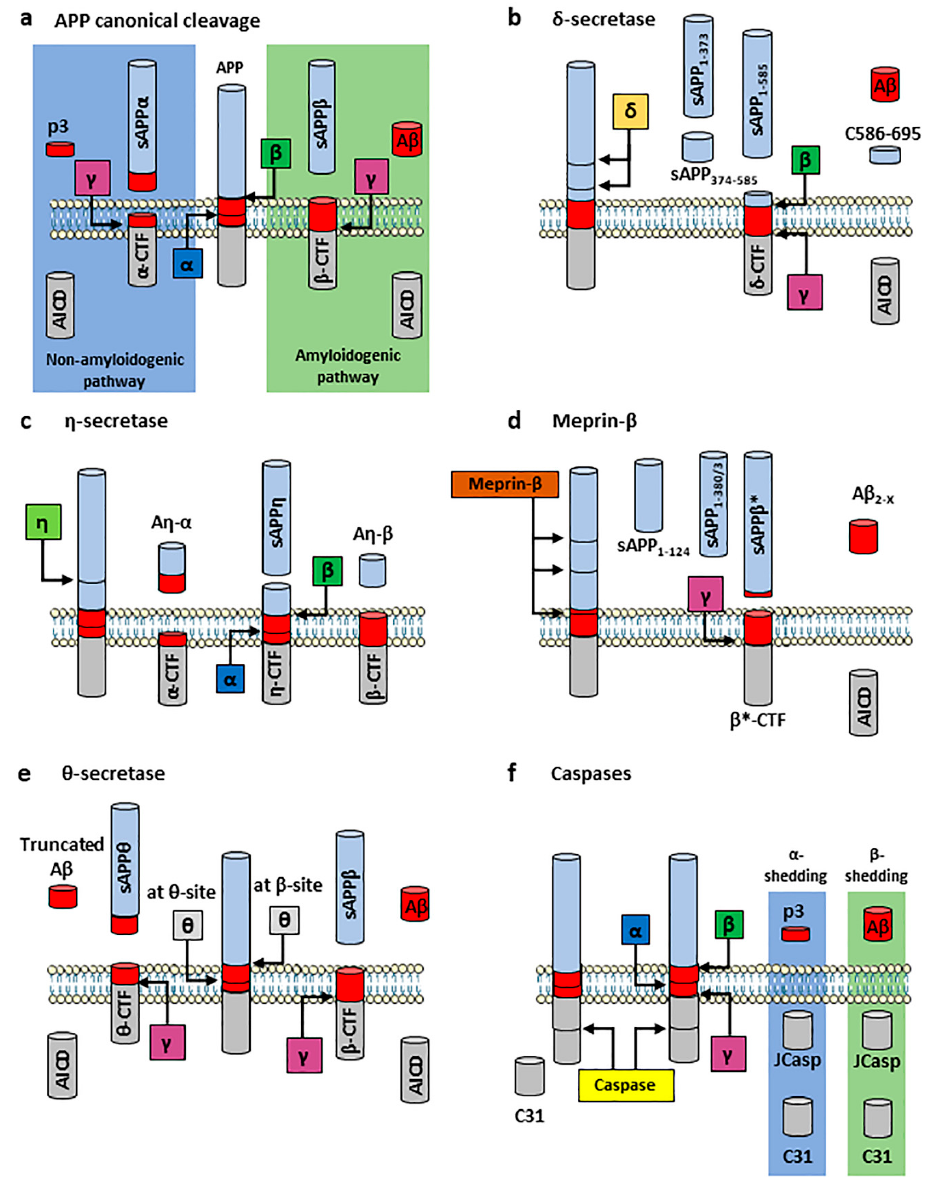
Figure 2. Schematic overview of APP-processing pathways. ( a ) APP canonical proteolytic processing. In the canonical cleavage, APP is either processed in the non-amyloidogenic pathway, where the sequential cleavage by α -secretase (ADAM10) ( blue square ) and the γ -secretase complex ( purple square ) produces sAPP α and p3, or in the amyloidogenic pathway, where the sequential cleavage by β -secretase 1 ( green square ) or Cathepsin B and the γ -secretase complex liberates sAPP β and A β . While α -produced AICD are rapidly degraded in the cytoplasm, β -generated AICD form the transcriptional factor ATF complex together with Fe65 and Tip60, that translocates into the nucleus to up-regulate APP-related genes (see text for details). ( b – f ) APP non-canonical proteolytic processing. ( b ) APP processing mediated by δ -secretase ( orange square ) releases three soluble APP fragments (sAPP 1–585 , sAPP 1–373 , and sAPP 374–585 ) and δ -CTF, which is further processed by β - and γ -secretases, releasing A β , AICD and the C586–695 fragment. ( c ) η -secretase ( light green square ) releases sAPP η and η -CTF, which is further processed by either α - or β -secretase 1, releasing A η - α or A η - β respectively; the remaining CTFs are cleaved by the γ -secretase complex, releasing p3 and AICD, or A β and AICD respectively. ( d ) Meprin- β ( brown rectangle ) produces sAPP β * (similar to sAPP β ) and two shorter soluble fragments (sAPP 1–124 and sAPP 1–380/3 ), while the remaining β *-CTF is processed by the γ -secretase complex, releasing AICD and A β θ -secretase ( grey square ) can either cleave APP 2–X . ( e )